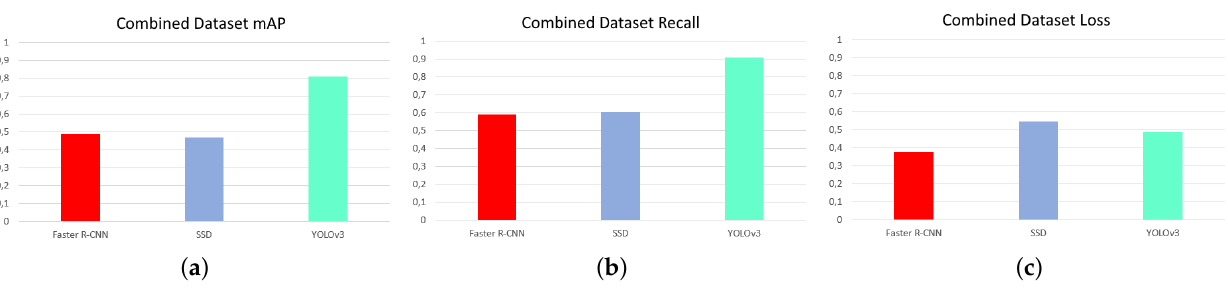
Figure 10. mAP, recall, and loss for networks with combined dataset. ( a ) mAP, ( b ) recall, and ( c ) loss. Source: